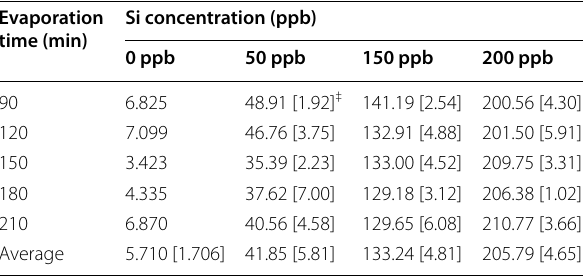
‡ Values within brackets denotes standard deviation